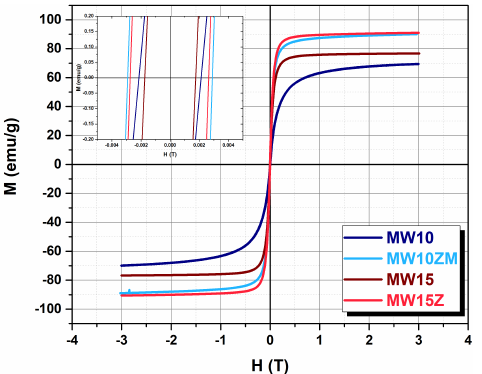
Figure 6. Hysteresis loops at 290 K for samples MW10, MW10ZM, MW15, and MW15Z. The 1 H-NMR measures at 1.5 T of the 1/T 1 and T 2 relaxation times as a function of the